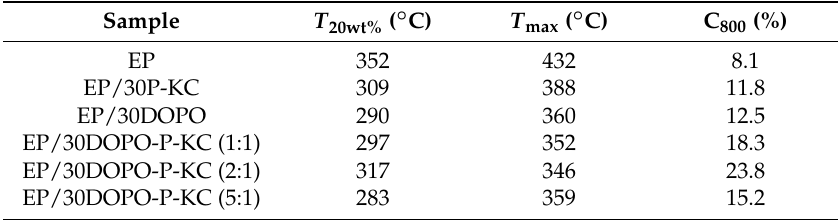
Table 3. Thermo-gravimetric analysis (TGA) and DTG data of FR-EP in N 2 atmosphere.